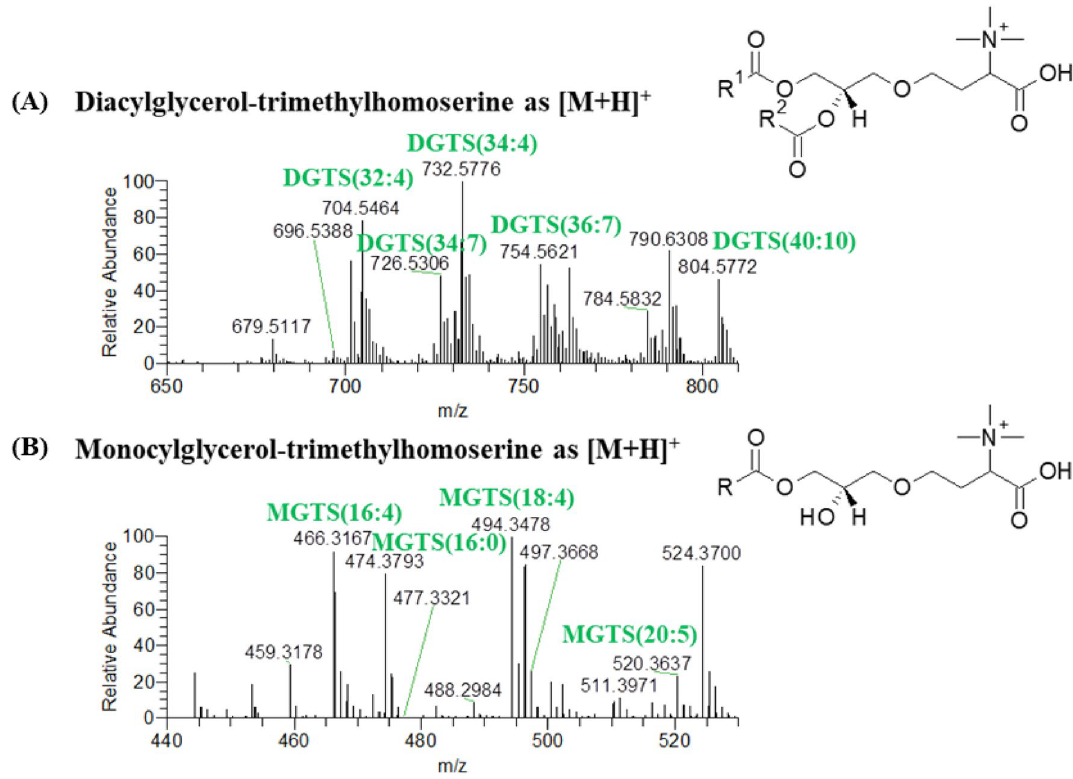
Figure 3. HILIC–HR–ESI–MS spectra of the classes of betaine lipids (BL) identified in positive ion mode as [M+H] + . These classes were ( A ) diacylglycerol-trimethylhomoserine (DGTS) and ( B ) monoacylglycerol- trimethylhomoserine